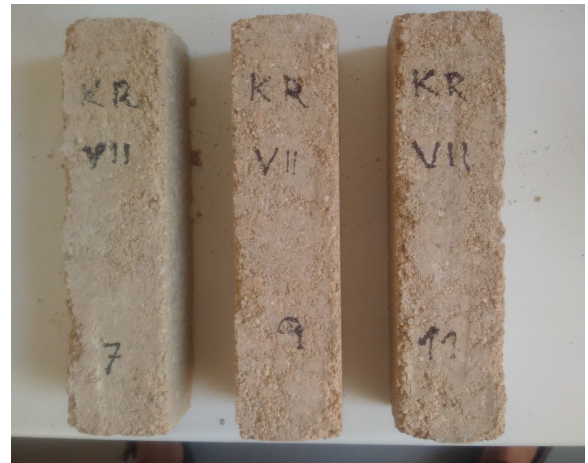
Figure 8. Specimens after testing.